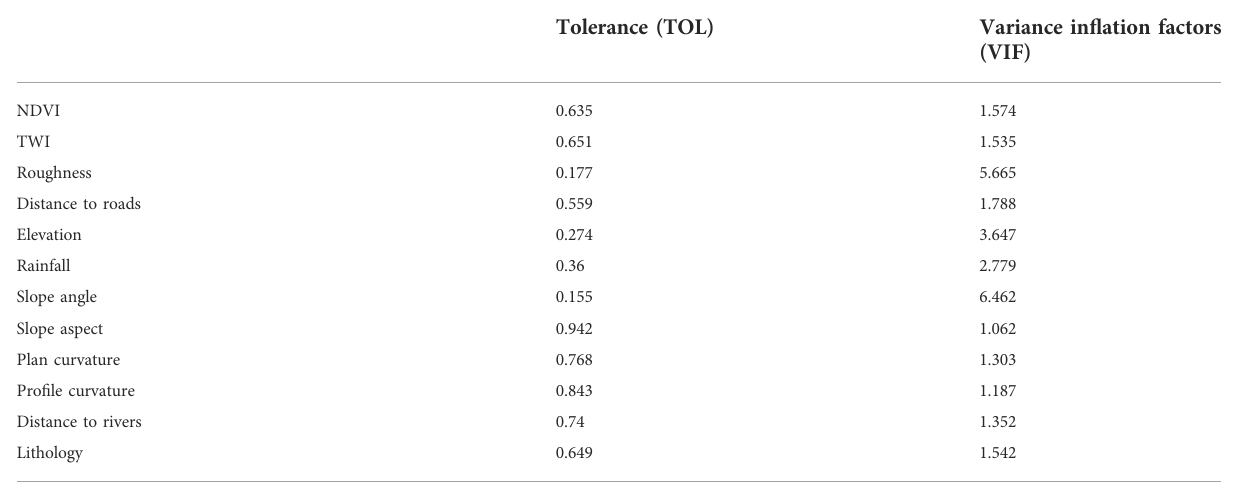
TABLE 1 Multicollinearity